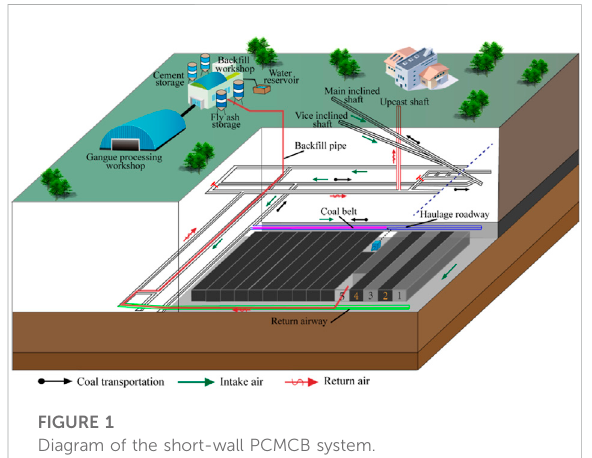
FIGURE 2 Surface subsidence model of short-wall